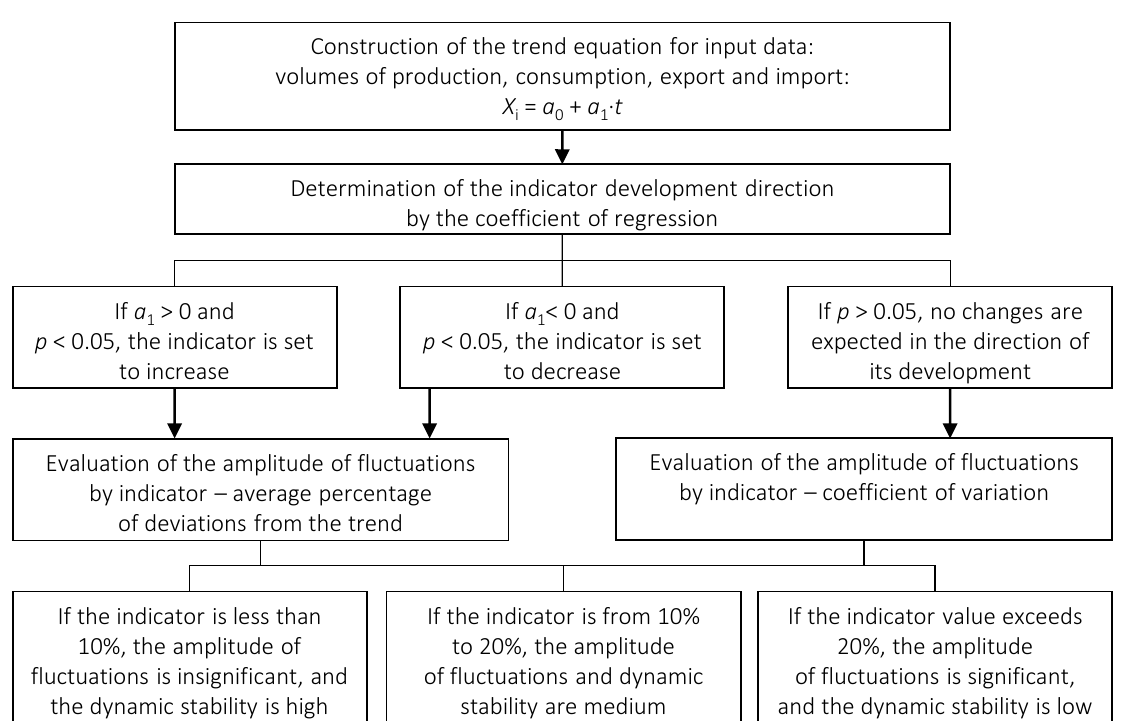
Figure 1. Algorithm for assessing the dynamic stability of sectoral food markets’